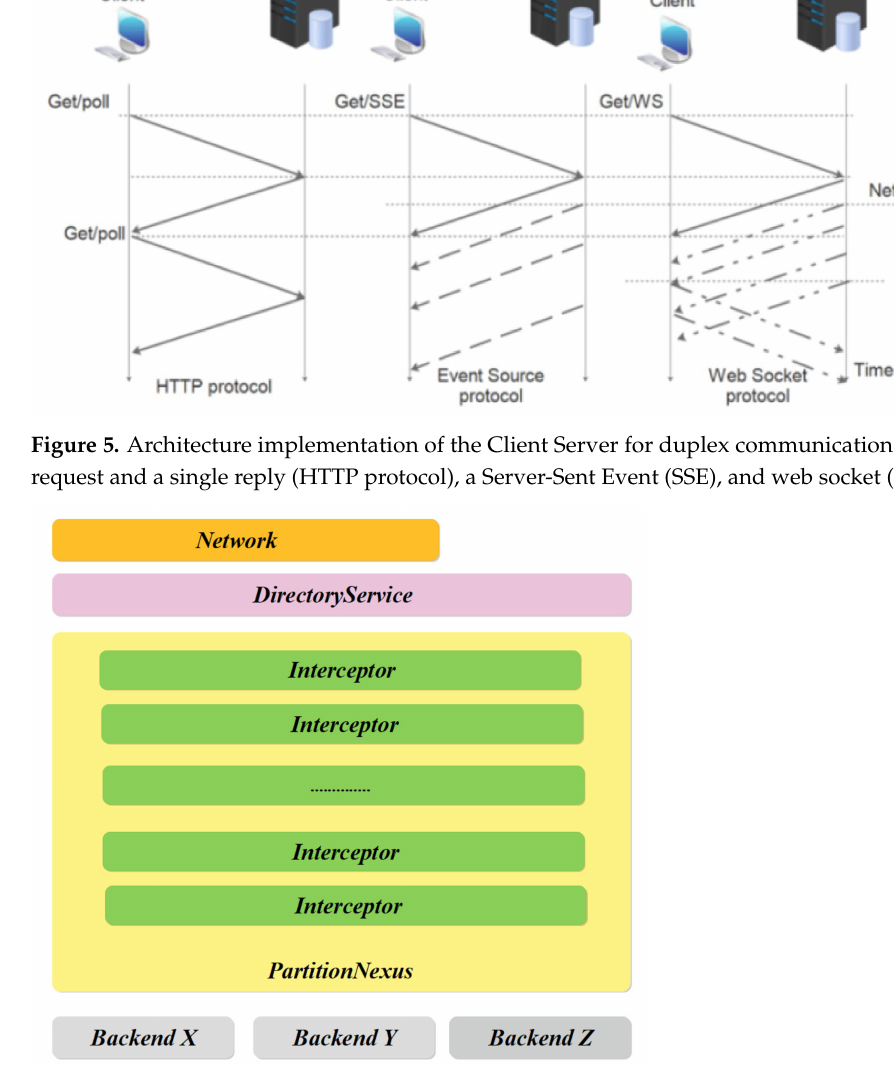
Figure 6. General architecture of the developed Apache